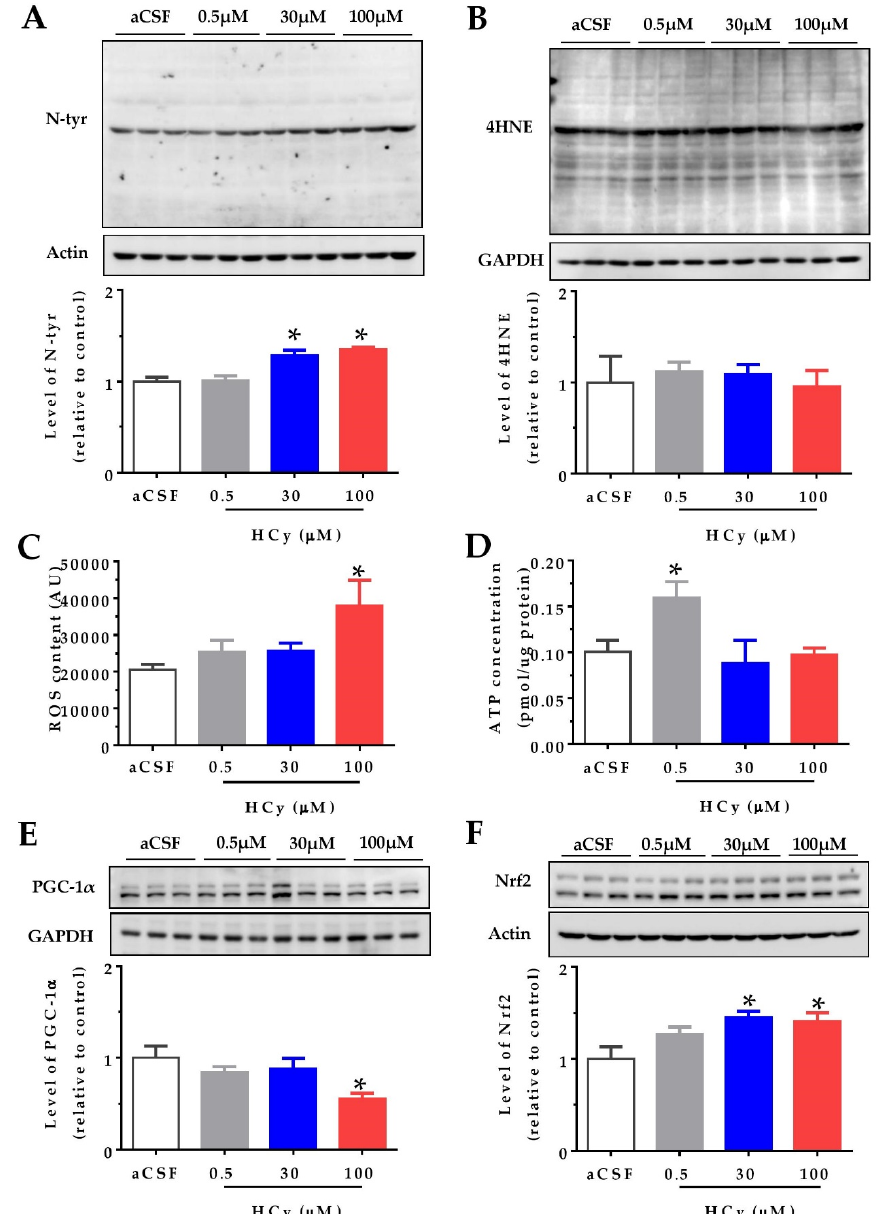
Figure 1. High concentrations of homocysteine (HCy) increase oxidative stress in the hippocampus. Levels of oxidative damage on hippocampal slices were evaluated after treatment with increasing concentrations of HCy (0.5, 30, and 100 µM) for 1 h. ( A ) Immunoblot against N-tyrosine (N-tyr) (above) and its densitometric analyses (below). ( B ) The 4-hydroxinonenal (4-HNE) antibody used to evaluate lipoprotein peroxidation levels (above) and their quantification (below). ( C ) Reactive Oxygen Species (ROS) content measured in the whole lysate using the fluorescent dye H2DCFDA. ( D ) ATP concentrations measured in the whole lysate using a bioluminescent ATP kit. ( E ) Levels of Peroxisome proliferator-activated receptor-gamma coactivator 1 alpha (PGC-1α) (above) and its quantification (below). ( F ) Immunoblot against nuclear factor erythroid 2-related factor 2 (Nrf2) (above) and quantification (below). Actin or GAPDH was used as the loading control. Protein levels were normalized against cerebrospinal fluid (CSF) solution-treated hippocampal slices. Each lane represents three independent samples (N = 3). A one-way analysis of variance (ANOVA) was performed followed by a Bonferroni post-test. Bars are the mean ± SEM. * p <